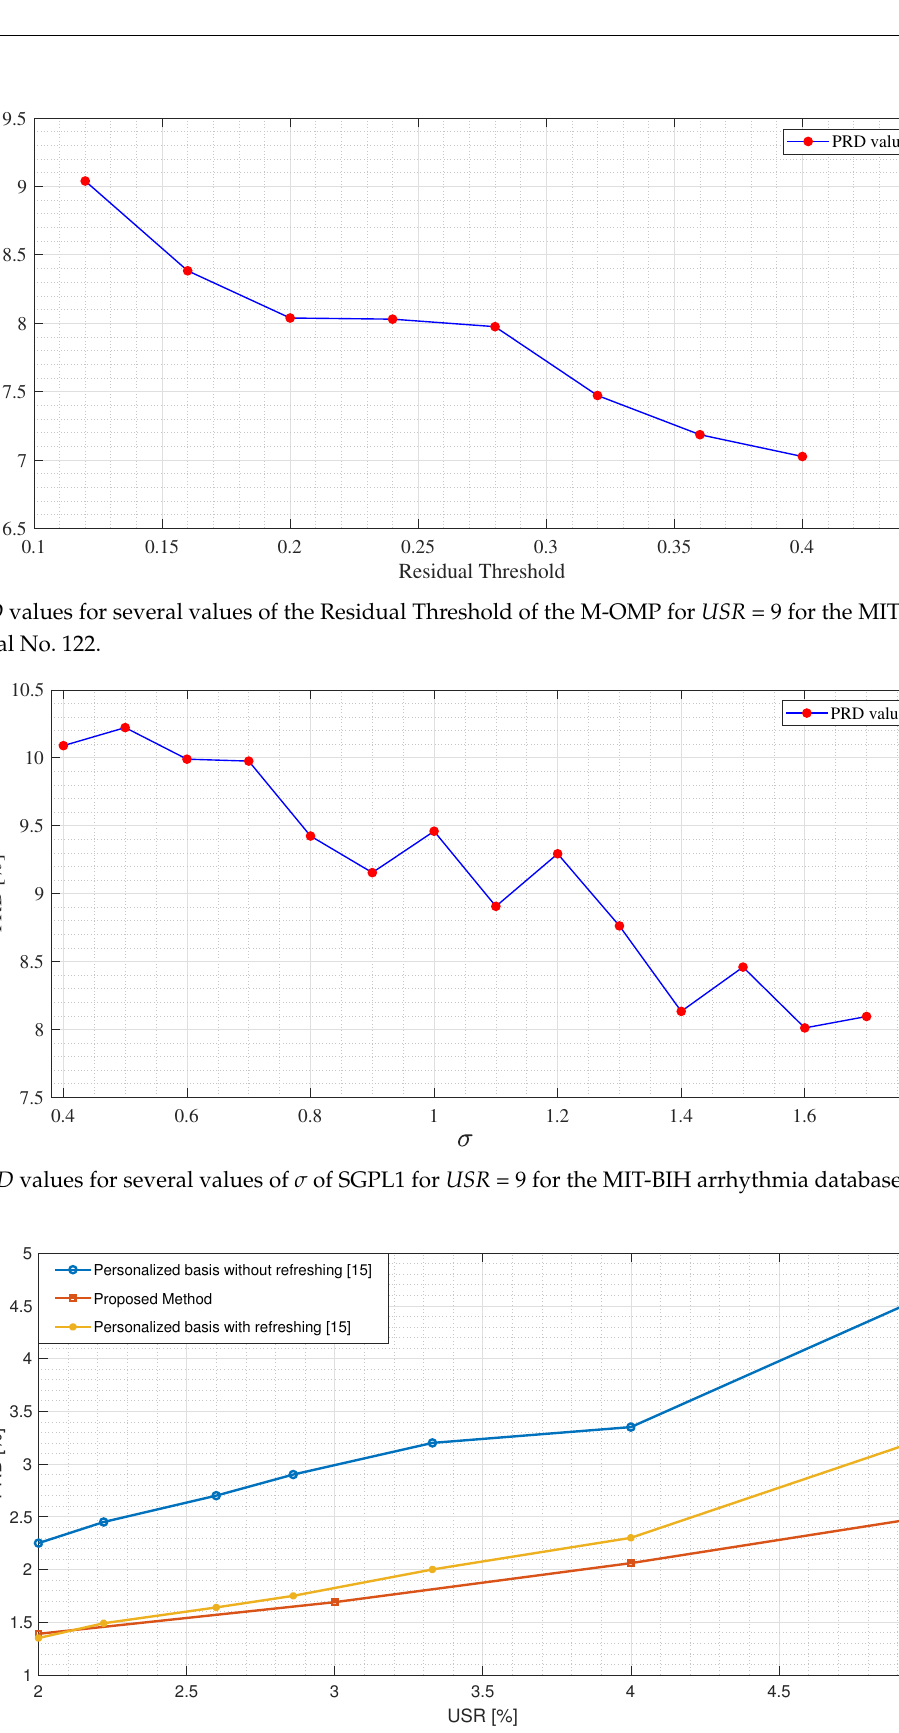
Figure 7. PRD value comparison between the proposed method and the method proposed in